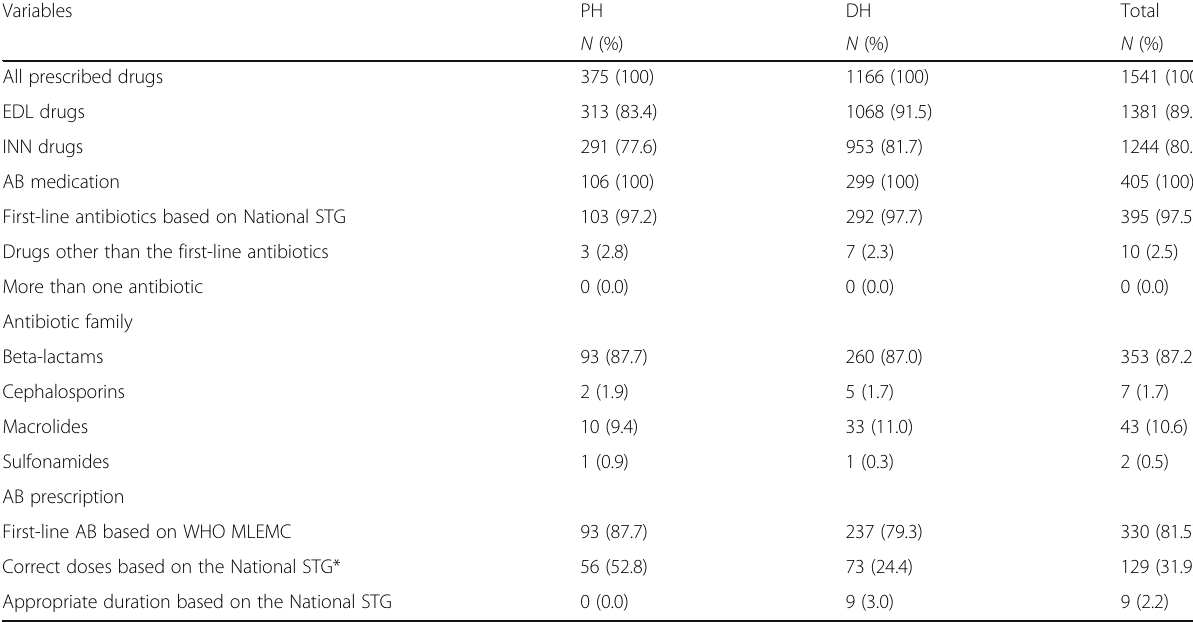
Table 6 Drug prescriptions for outpatients under 5 years of age at provincial hospital (PH) and district hospitals (DH)